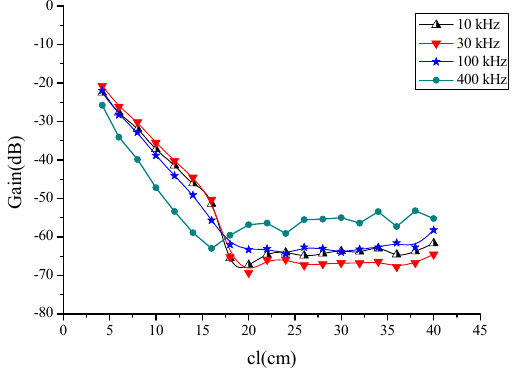
Figure 4. Mean values of the intra-body communication channel characteristics, measured on six test subjects at different frequencies over a period of several days.